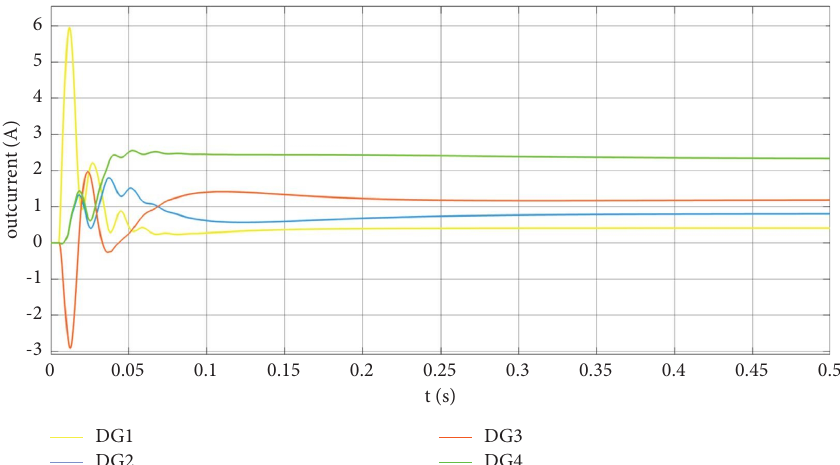
Figure 8: Output current under proportional current sharing.